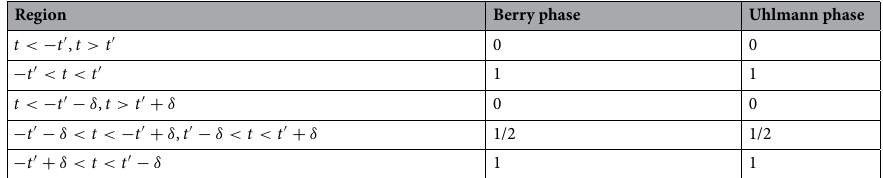
Table 1. A comparison of different pure and mixed state geometric phases of SSH chain for short-range coupling ( α ). The top and bottom tables represents the Hermitian and non-Hermitian SSH cases → ∞ respectively. The Berry phase and Uhlmann phases are calculated through Eqs. (4) and (10) respectively. Here 1 the geometric phases are quantized in the units of π with t ′ = 0 ) and t δ( k δ( k π) which separate phases t ′ t ′ The criticality condition is given by t = − ± = = ± = 1 as shown in Fig. 2b. Instead of single gap closing point, we get two exceptional points 0, 1 / 2 and W W = = which also produce two parameter spaces for the WVs. The combined effect in the parameter spaces decides the topological behavior of the system. The EWVs are given by,